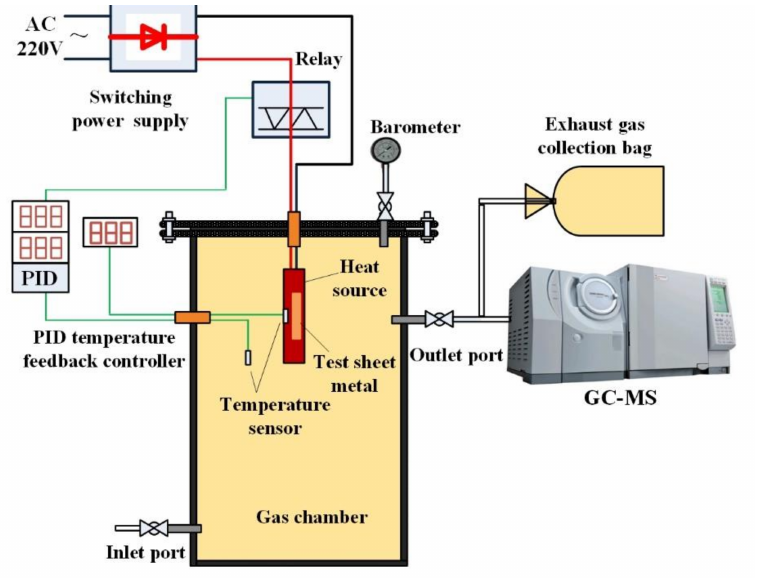
Figure 1. Experiment